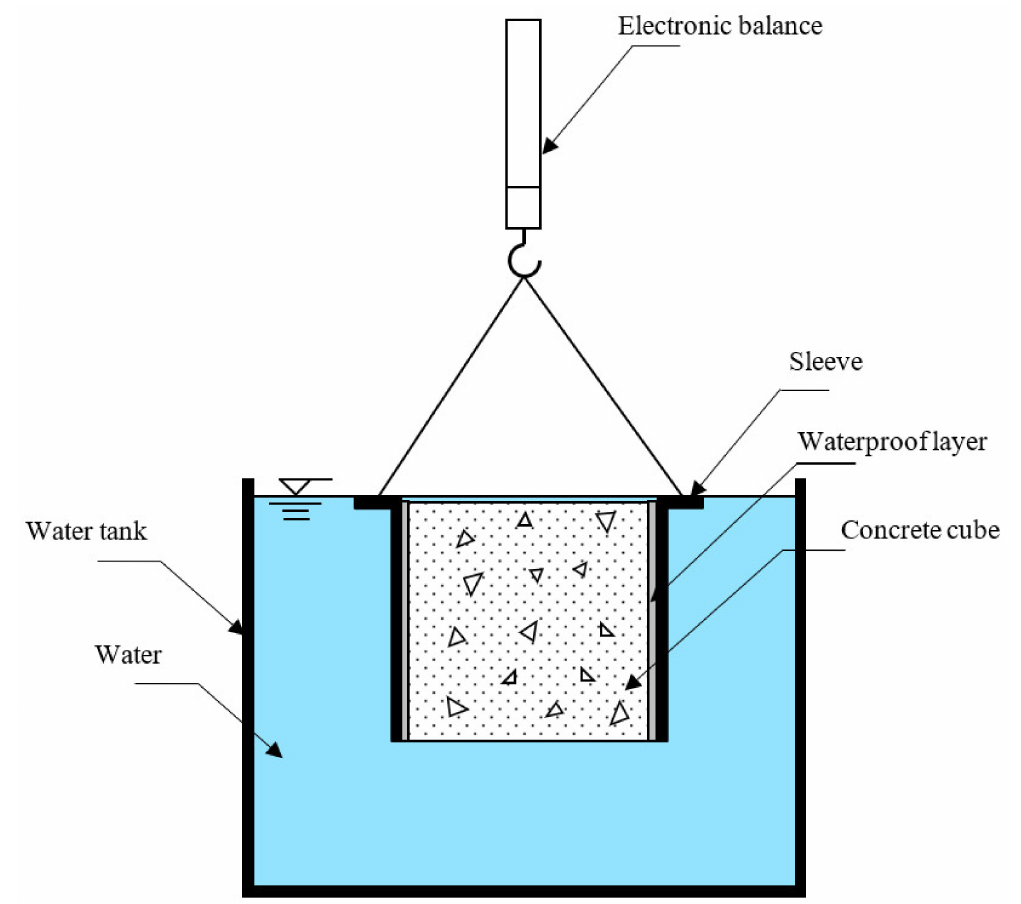
Figure 5. Schematic diagram of interconnected porosity test.